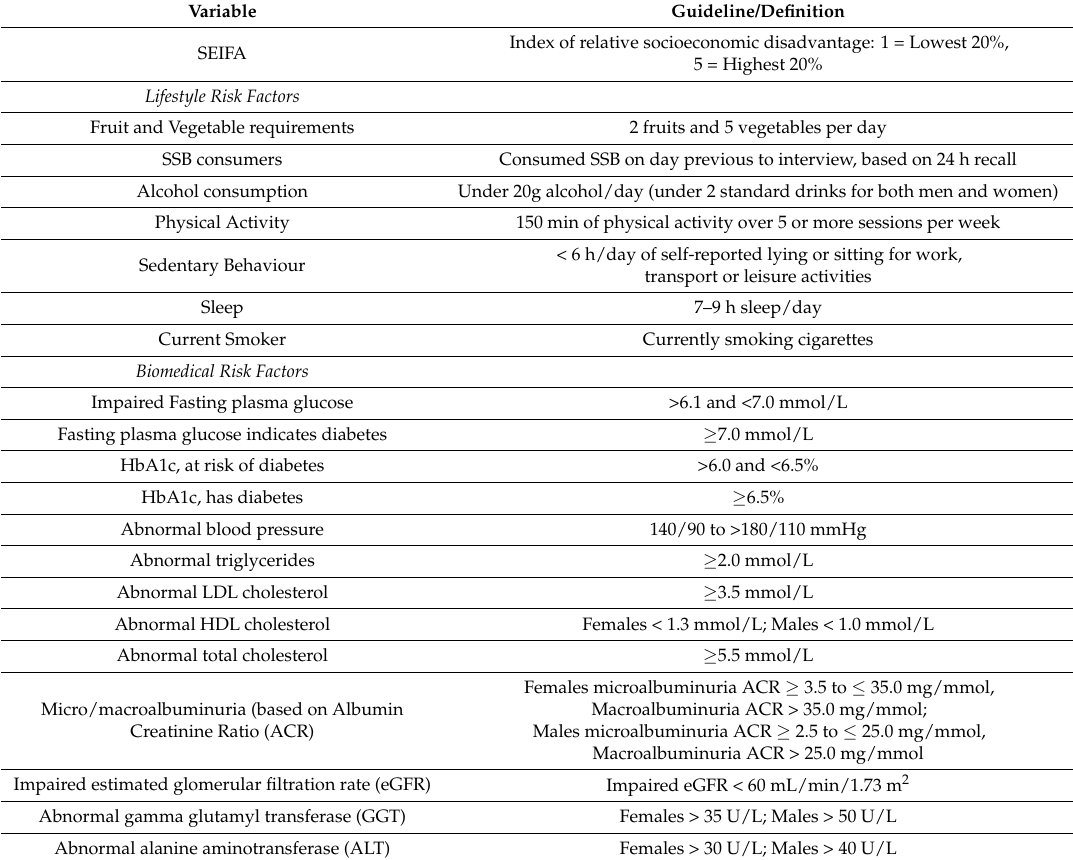
Table 1. Definitions of lifestyle and biomedical categorical